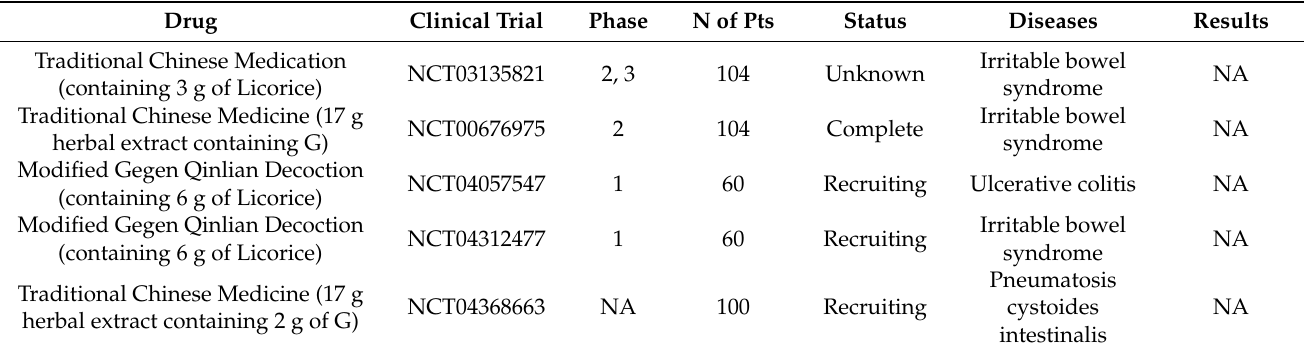
Figure 2. Molecular mechanisms of Glycyrrhiza glabra -derived compounds in intestinal disorders. Compounds derived from Glycyrrhiza glabra have anti-inflammatory potential. G, GA, and DPG act through the inhibition of HMGB1, TLR4, and RAGE receptors and significantly regulate important cytokines, interleukins, and genes involved in the inflammatory process. These effects are related to the capacity of regulating important inflammatory signaling pathways such as HMGB1, NF- κ B, and MAPK. Oxidative stress is significantly reduced because of cellular and molecular changes, and consequently, the inflammatory process is attenuated as a result of treatment with these compounds.